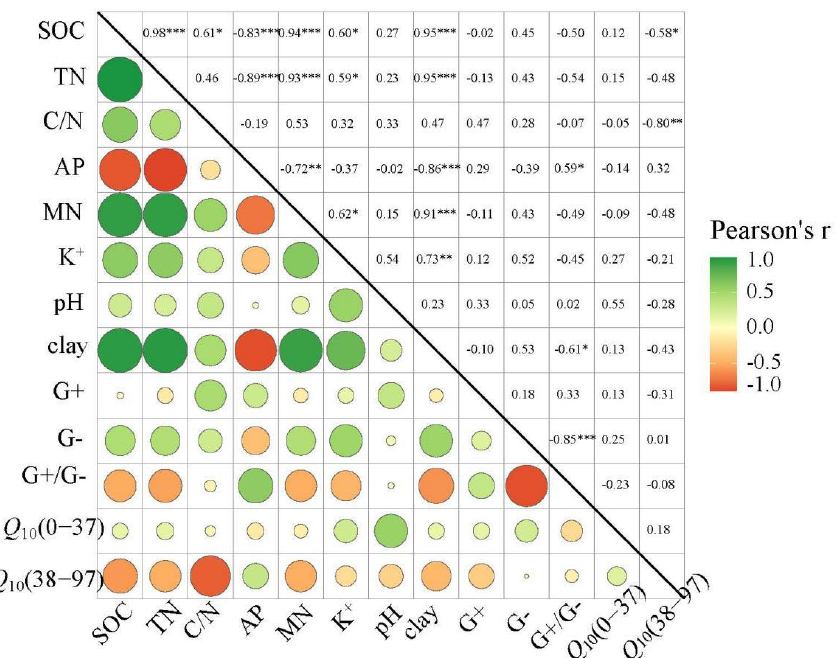
Figure 3. Pearson’s correlation coefficient matrix of Q 10 with key important influencing variables.